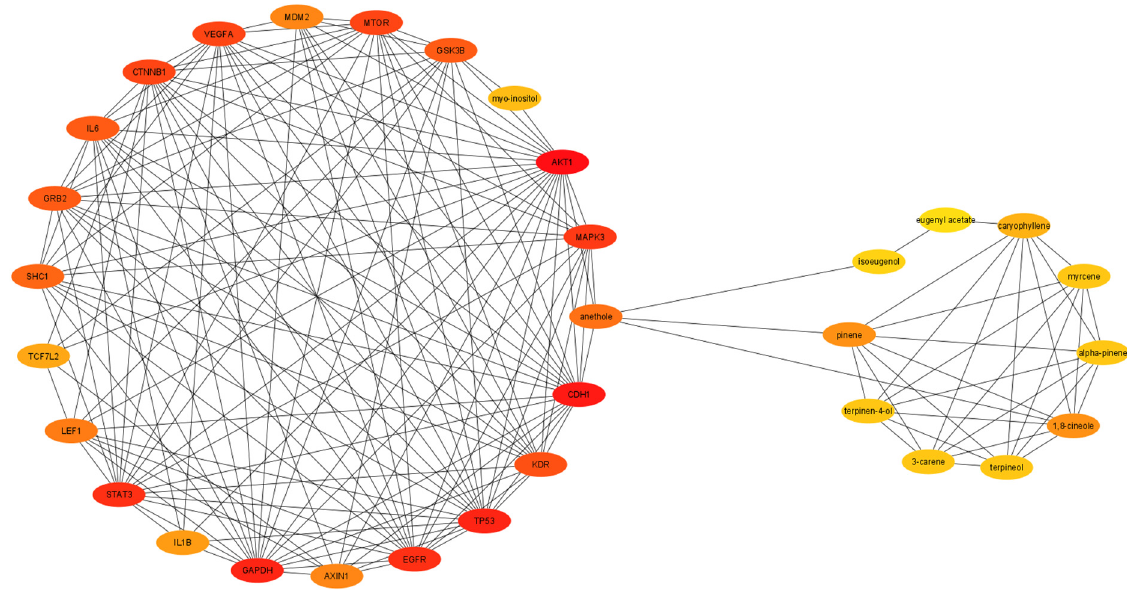
Figure 4. Compound target network obtained using Cytoscape (significance based on color intensity).